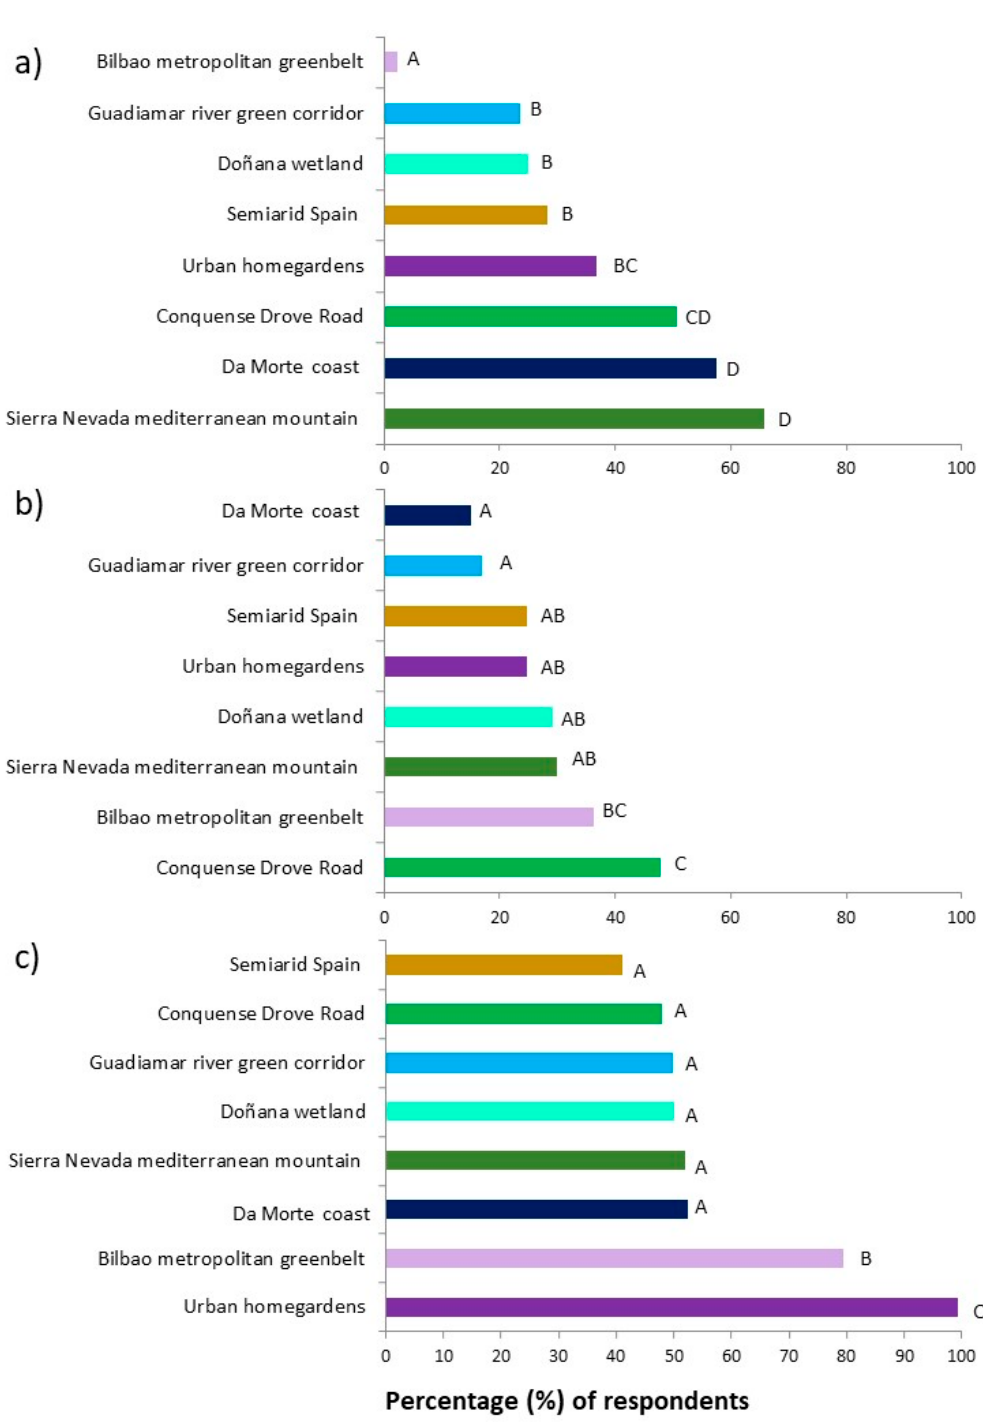
Figure 2. Social importance of ecosystem services (ES) categories (in % of respondents) in each ecosystem type: ( a ) provisioning, ( b ) regulating, ( c ) cultural. Differences in perceived importance among ecosystem types were identified by letters representing significantly different groups as identified by the Dunn test at p -value < 0.05.